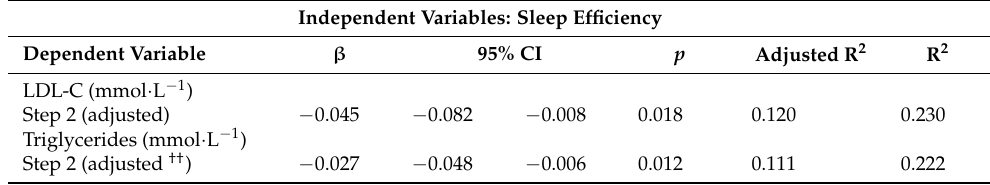
Table 4. Linear regression model examining the association between LDL-C, triglycerides, and sleep efficiency after adjusting for potential confounders in the entire